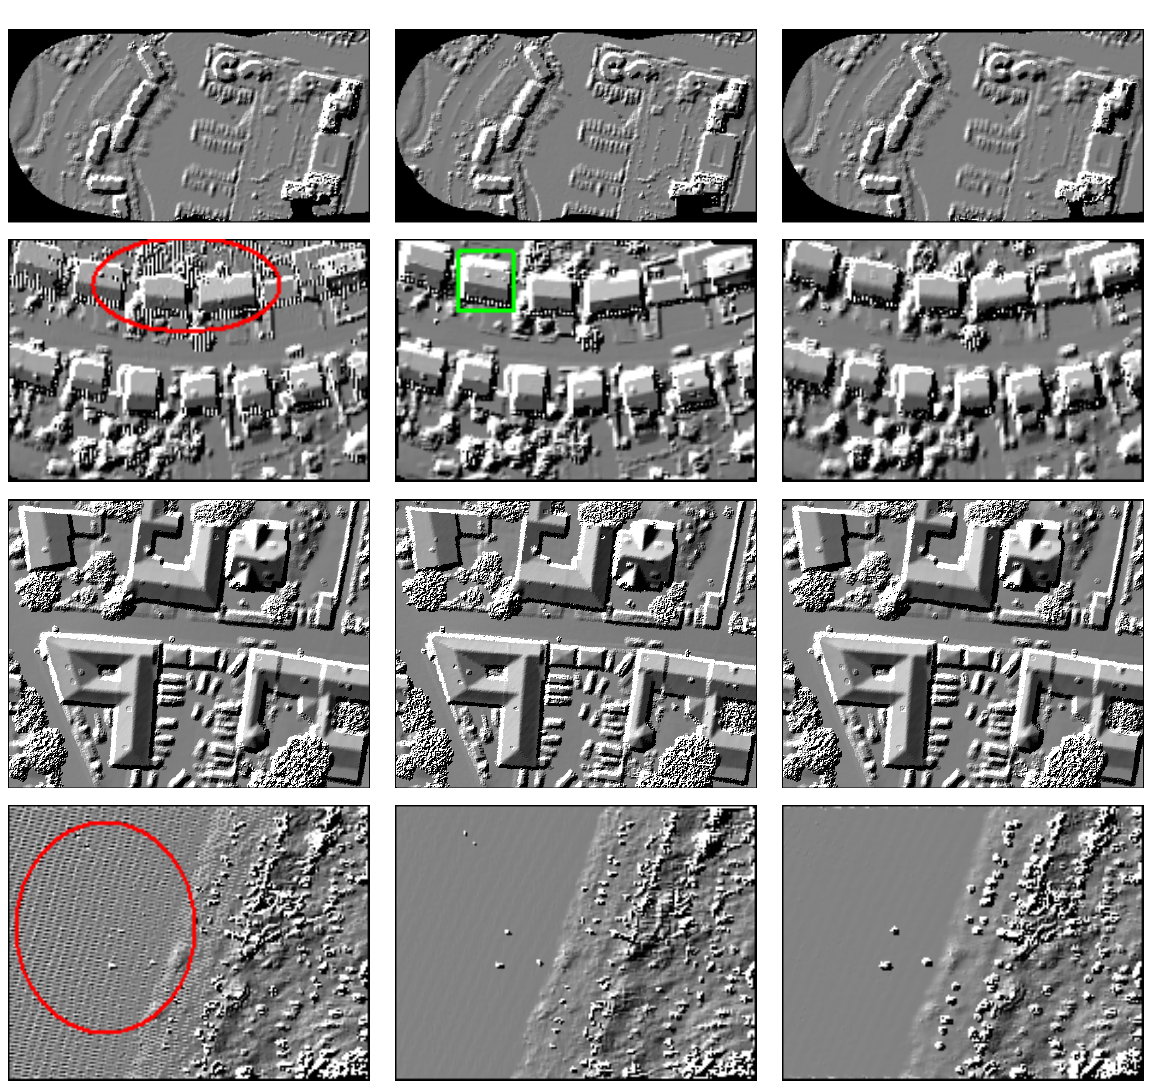
Figure 5. Shading results of data sets; Strong interpolation artefacts are visible in the left column marked by the red circle; Interpolation methods from left to right: k NN16, quad k NN8 and incCir; Data set from top to bottom: ALS-PAL, ALS-OSC,